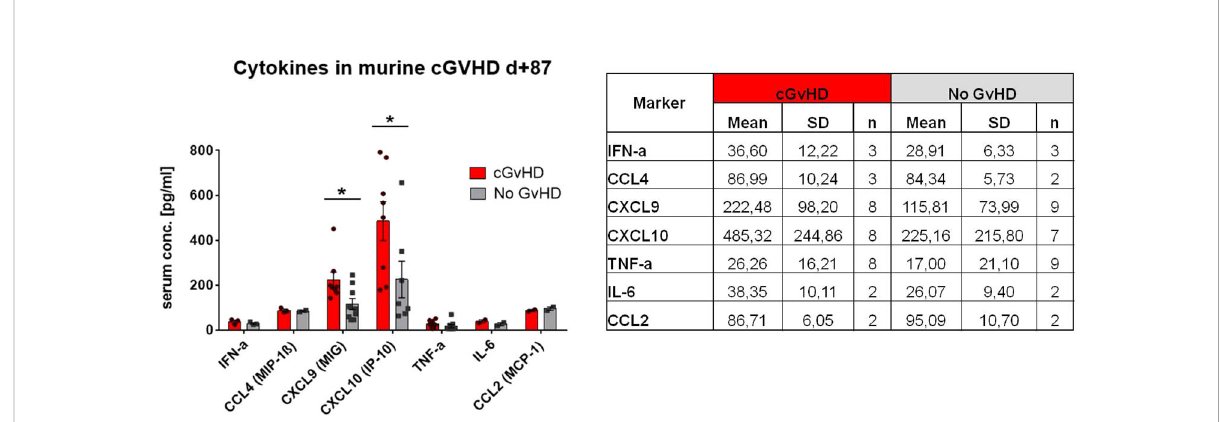
FIGURE 7 Cytokine levels in serum of cGvHD vs. non-GvHD in C57BL/6 ➔ BDF1 model at day+87 after transplantation. Table shows mean+SD for each analyzed marker. Graph illustrates cytokine serum concentration in pg/mL. Error bars show mean ± SEM. Representative data from one experiment. *P<0.05, by unpaired students